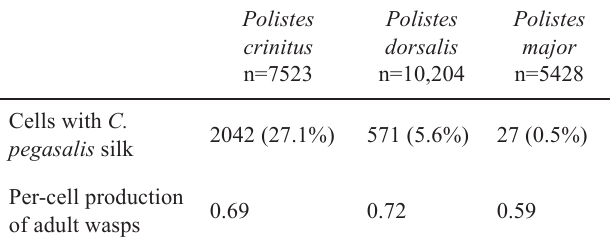
Table 2 . Frequency of cells with apparent Chalcoela pegasalis silk and per-cell production of adult wasps in old nests of three Jamaican social wasps. Total numbers of cells below each species are from the nests enumerated in Table 1. Per-cell production of adults is based on counts of fecal pellets in cells bases; e.g. the 7523 cells of the P. crinitus nests contained an estimated 5203 pellets, a mean of 0.69 per